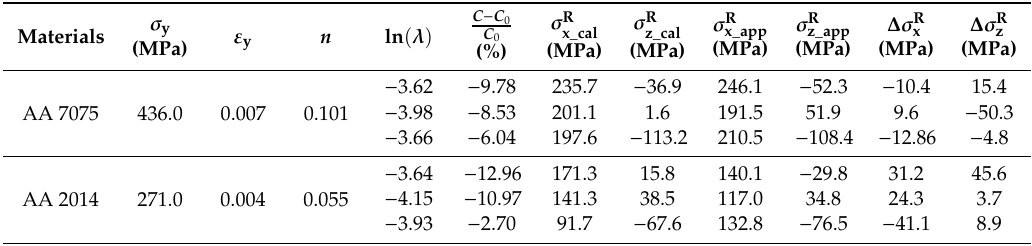
Figure 10. The typical top-view morphology of residual indentation imprint after spherical indentation for (a) AA 7075 and (b) AA 2014 with non-equibiaxial residual stresses, and (c) the micrograph of grain structures of AA 7075.